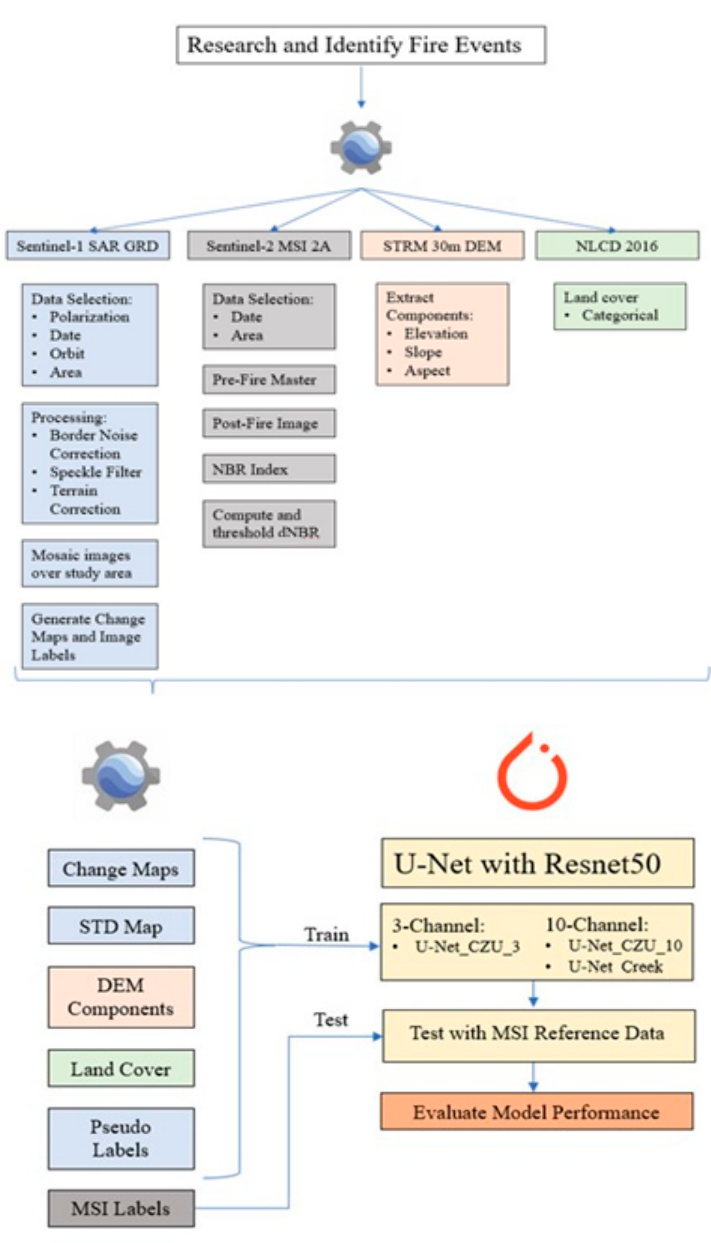
Figure 3. Flow chart overviewing the data collection and modeling presented in this